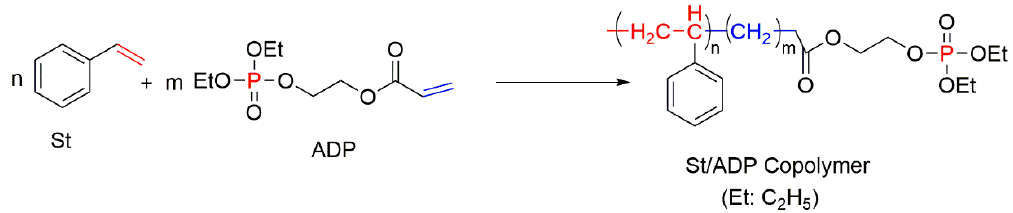
Figure 17. Free radical copolymerisation of styrene (St) with 2-(acryloyloxy)ethyldiethylphosphate (ADP) [109].